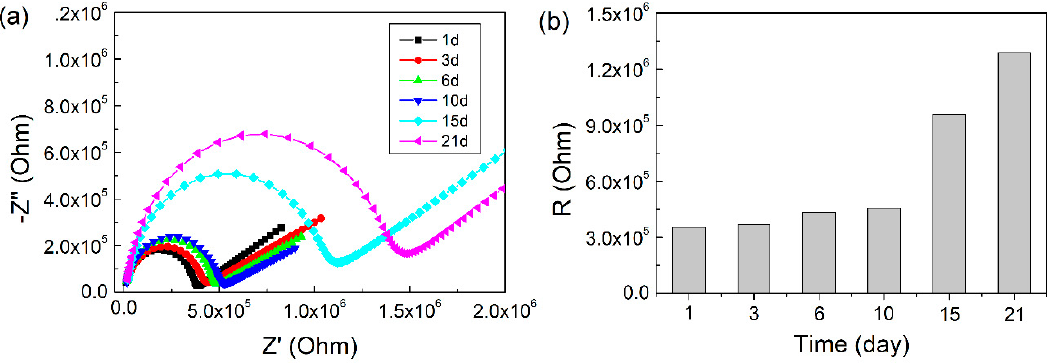
Figure 6. ( a ) Nyquist diagrams of Pickering emulsions with different standing time and ( b ) corresponding fitting resistance values. Table 3. Equivalent circuit fitting electrical values of Pickering emulsions at different storage times.